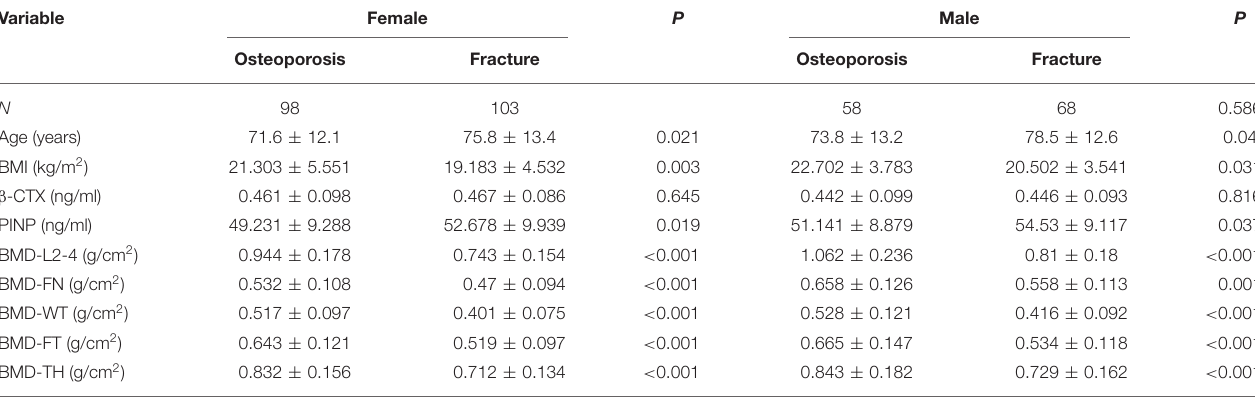
TABLE 2 | Characteristics of the study population.